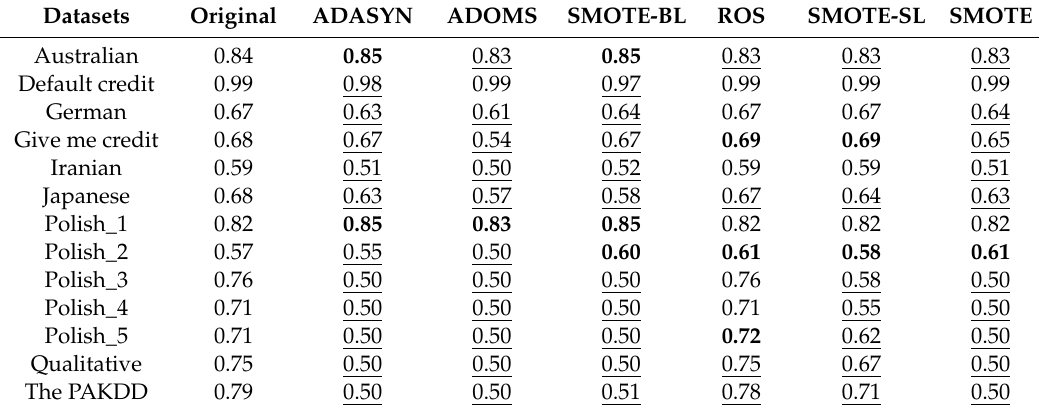
Table 12. AUC for the Extended Gamma classifier after oversampling algorithms.